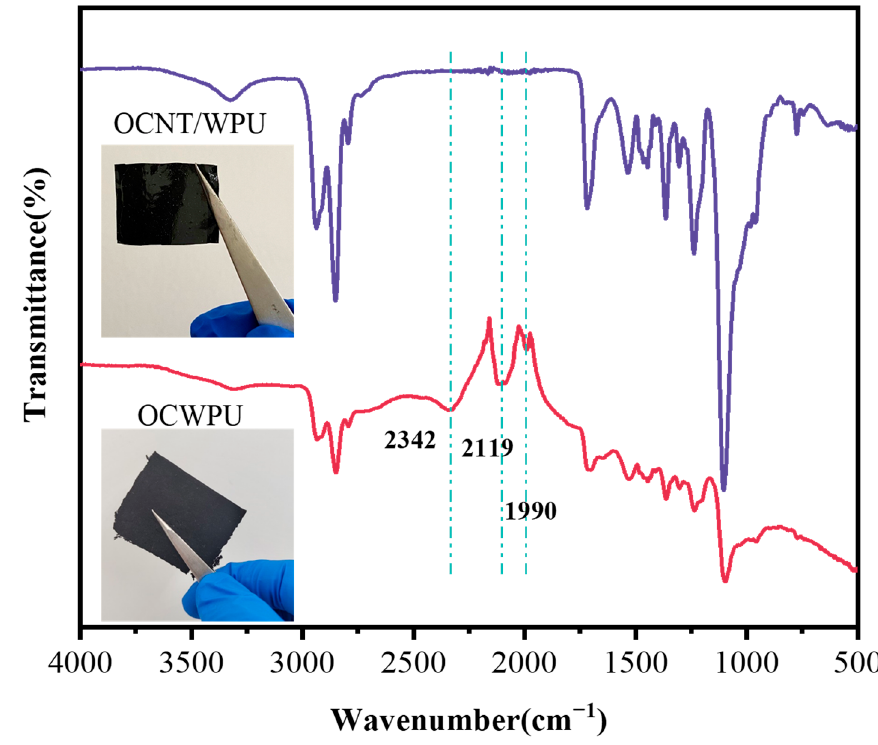
Figure 3. FT-IR of OCNT/WPU and OCWPU.